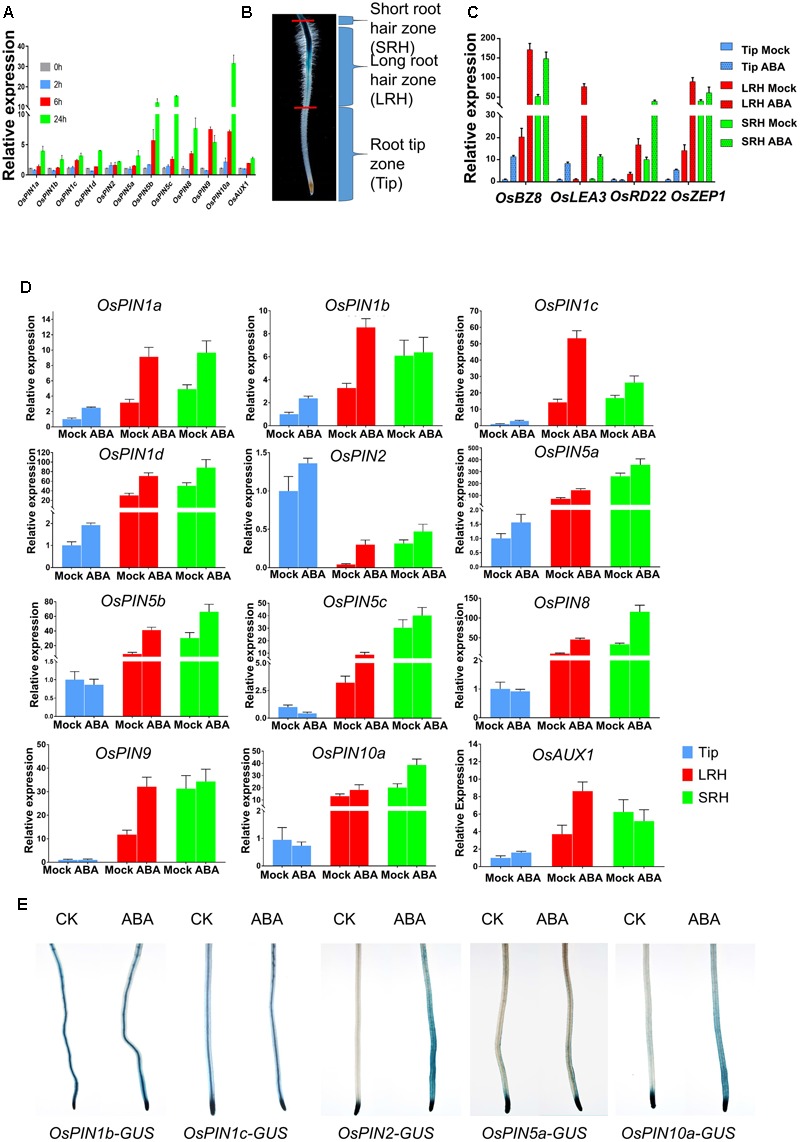
ABA regulates the expression of OsPINs to promote polar auxin transport in root tips. (A) Expression of OsPINs is induced by ABA in 5-day-old rice roots. Expression of each PIN gene was determined by quantitative RT-PCR and 2 μM ABA was used in this assay. OsActin1 was used as an internal control. Three replicates were conducted. Data are means ± SD. (B) Definition of the root hair zones. Root tips were divided into three regions: short root hair zone (SRH), long root hair zone (LRH), and root tip zone (Tip). Each region was cut and collected from at least 96 five-day-old seedlings with or without 0.5 μM ABA treatment for 24 h. (C) Expression of ABA-responsive genes OsLEA3, OsBZ8, OsZEP1, and OsRD22 in the Tip, LRH and SRH zones after ABA treatment. Data are means ± SD. (D) Quantitative RT-PCR analysis of OsPINs in the SRH, LRH and Tip treated with or without 0.5 μM ABA for 24 h. The expression level of each gene in the untreated Tips was defined as “1.” Data are means ± SD. (E) The GUS activity of the OsPINs-GUS in the 5-day-old rice seedlings in response to 0.5 μM ABA for 12 h.